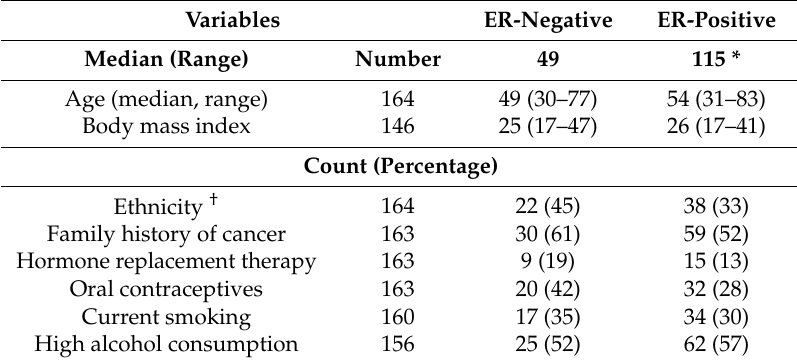
Table 2. Characteristics of 164 female breast cancer patients subdivided according to tumour pathology into estrogen receptor (ER) positive ( n = 49) and negative ( n = 115)